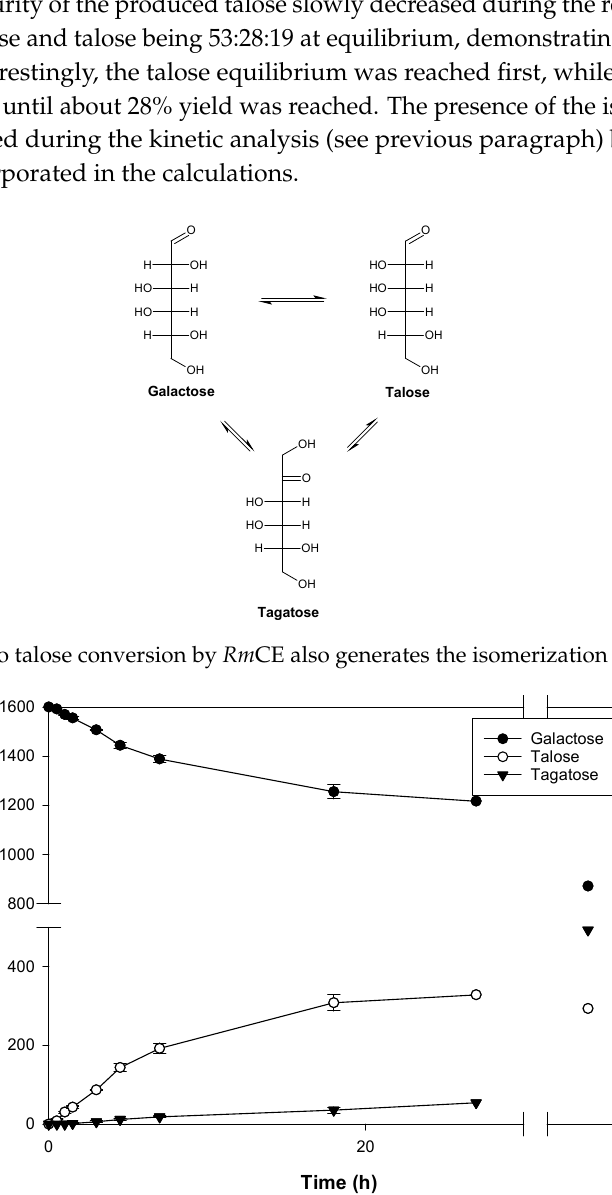
Figure 2. Time-course representation of galactose to talose/tagatose conversion. The reaction was performed with 1.6 M of galactose at pH 6.3 and monitored for 27 h at 70 ◦ C. During the first hours, talose was being formed time-dependently, reaching a maximum conversion of about 20% after overnight incubation. Formation of tagatose seemed to lag in the beginning of the reaction but increases linearly after one hour. The tagatose equilibrium was only reached after 120 h, during which extra enzyme was added to speed up the reaction. Data represent the means of three experiments with standard deviation (until 18